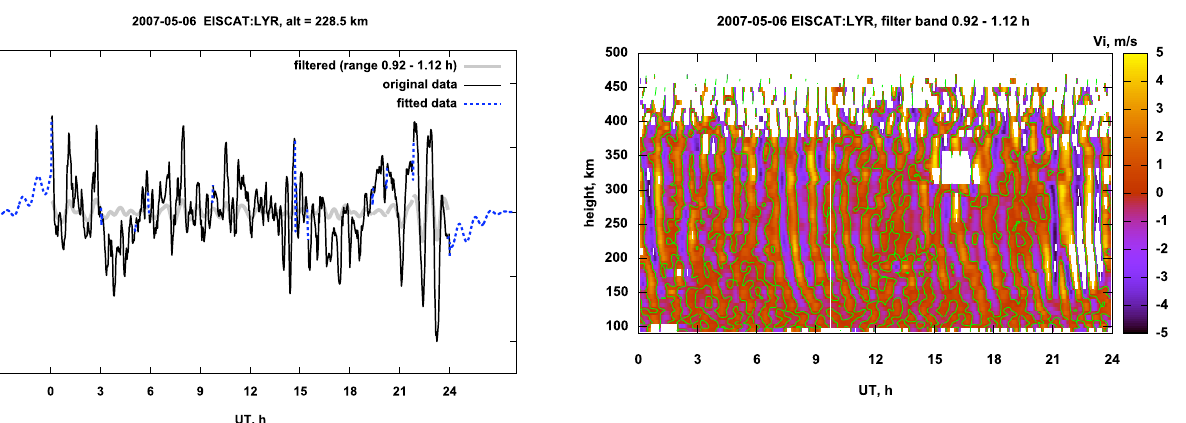
Fig. 8. Filtered field-aligned ion velocity data on 6 May